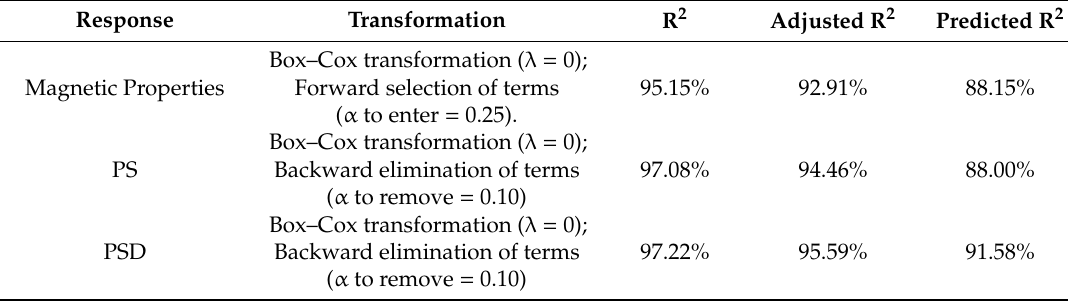
Table 3. Summaries of models revealed in Equations (1)–(3) and performed